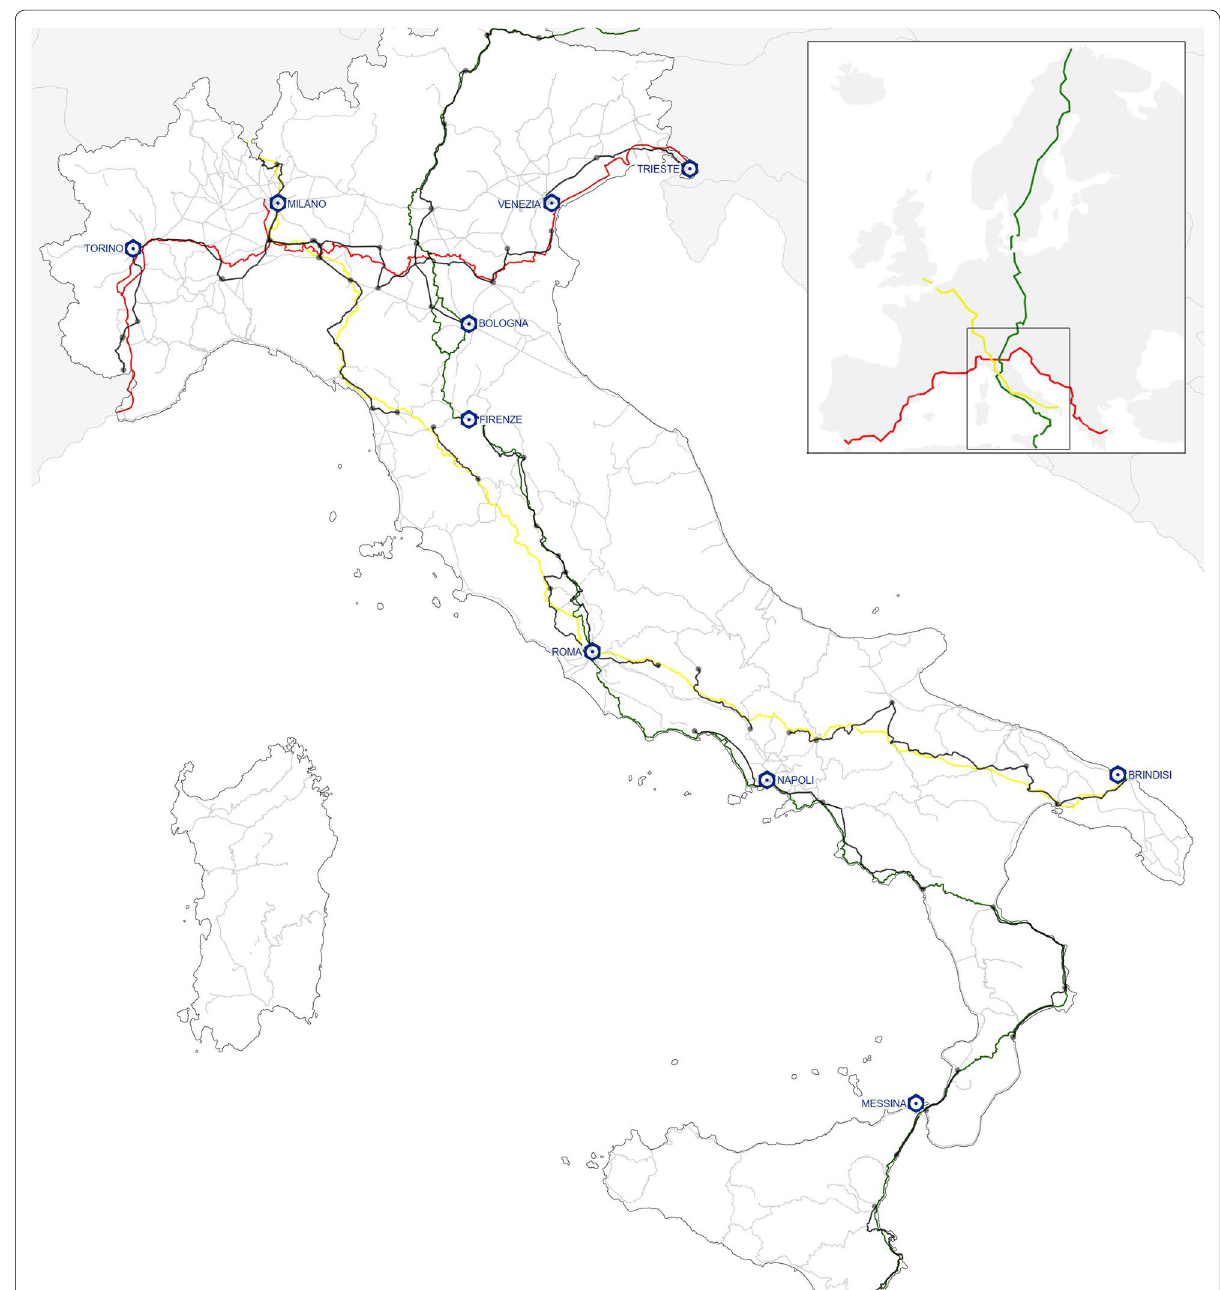
Fig. 13 EuroVelo paths planned (EV 5, yellow, EV 7, green, EV 8, red) and railway lines in their proximity (dark